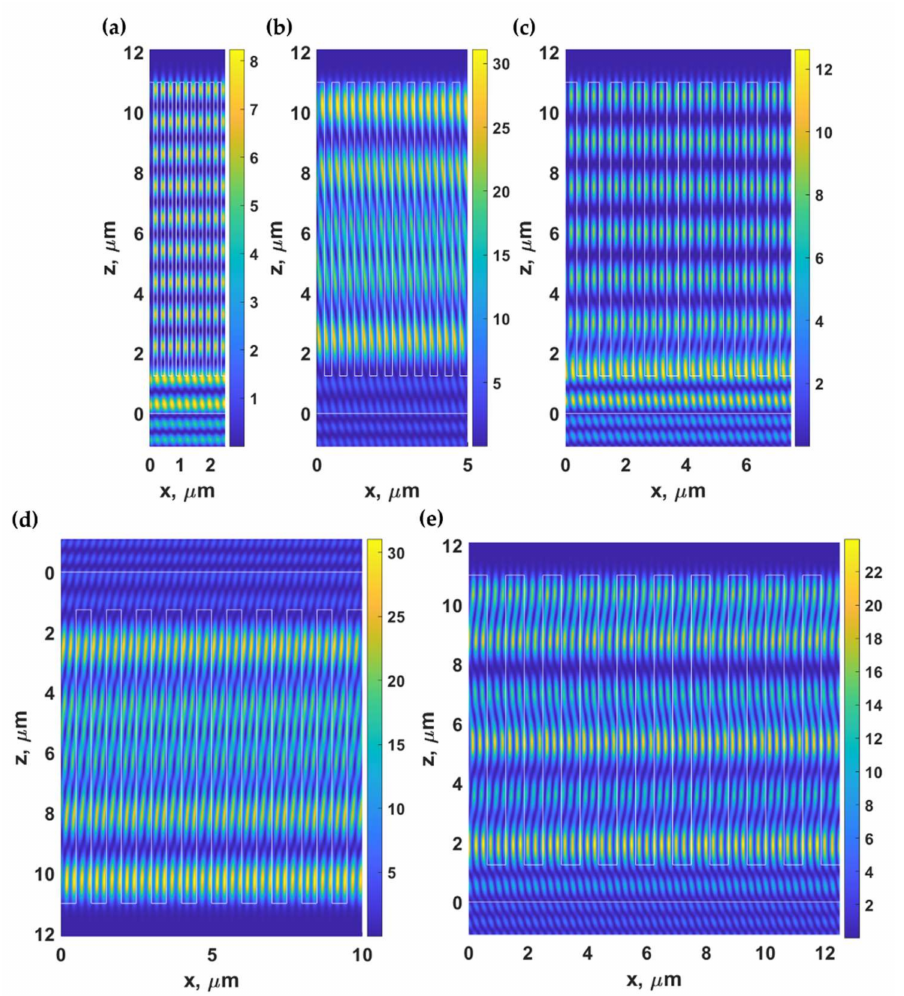
Figure 10. H 2 y field distribution calculated using RCWA for gratings with ( a ) λ g, DWG of 0.25 µ m ( m of 1), ( b ) 0.5 µ m ( m of 2), ( c ) 0.75 µ m ( m of 3), ( d ) 1 µ m ( m of 4) and ( e ) 1.25 µ m ( m of 5) with F.F. of 0.5, d of 11 µ m and d g of 9.75 µ m, when illuminated by TM polarized light at 685 nm and the n 0 sin θ 0 of